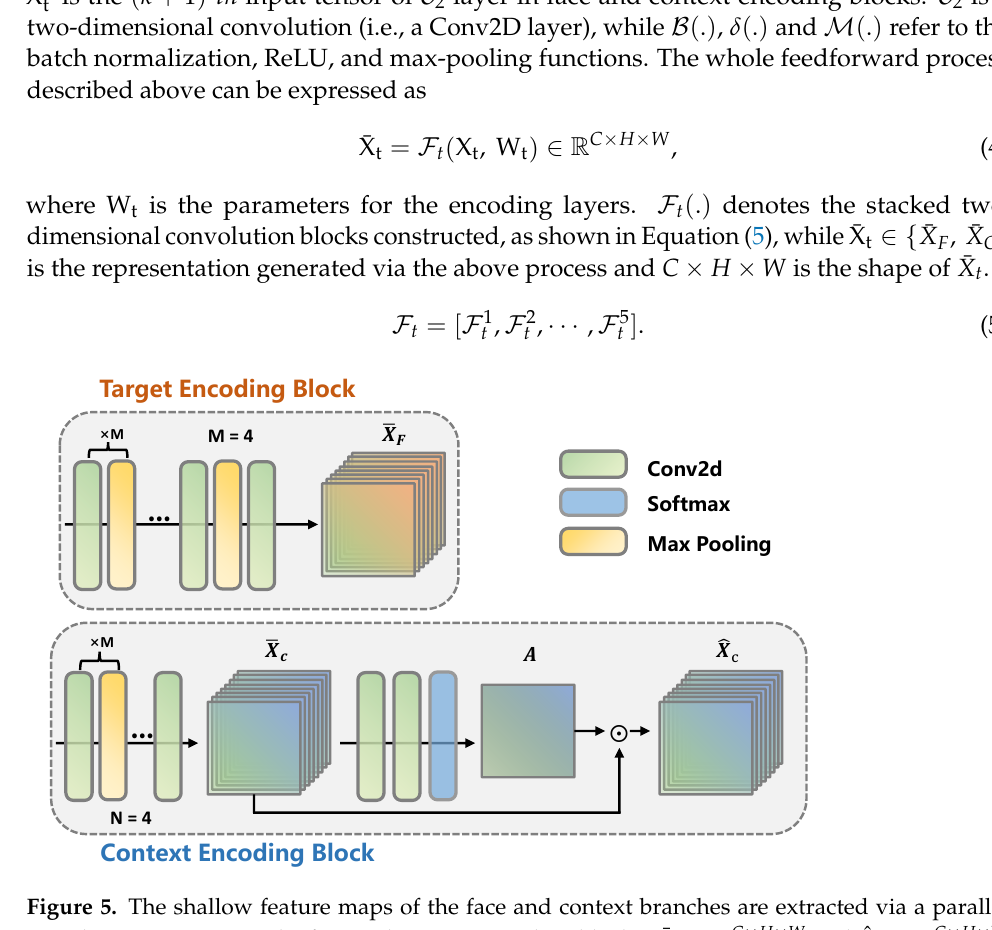
Figure 5. The shallow feature maps of the face and context branches are extracted via a parallel encoding process using the face and context encoding blocks. ¯ X F ∈ R C × H × W and ˆ X C ∈ R C × H × W are the corresponding results. (cid:12) denotes the element-wise multiplication. “ × M ” means that the enclosed part is performed M